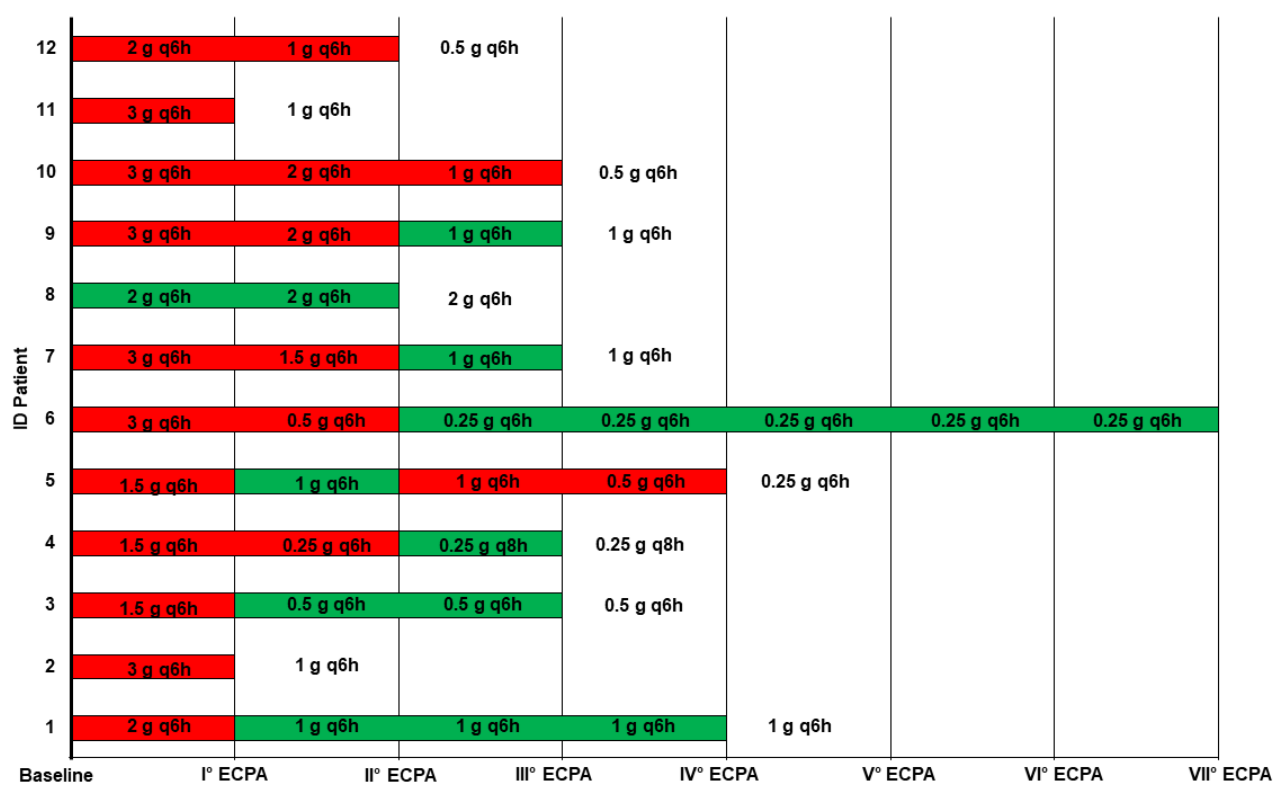
Figure 1. Recommended ampicillin dosing adjustments for each instance of TDM-guided expert clinical pharmacological advice in patients with documented or suspected enterococcal bloodstream infections and/or infective endocarditis. Green box: no recommended ampicillin dosing adjustment; red box: recommended ampicillin dosing reduction; ECPA: expert clinical pharmacological advice.